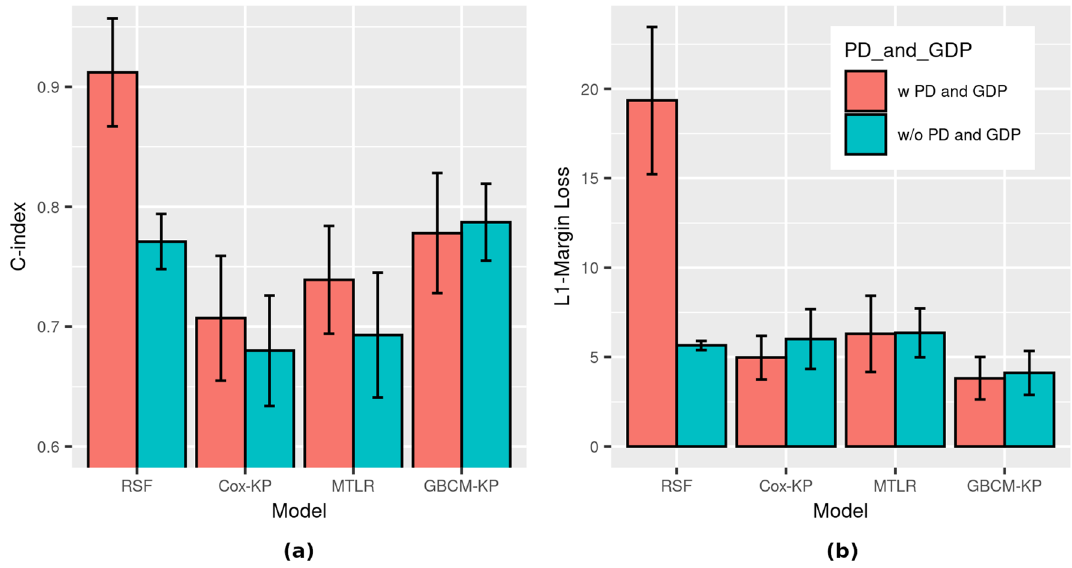
Figure 5. Survival prediction performance on dataset D3[h] (N = 1422) for hospital discharge as event of interest with age, sex, chronic disease (binary indicator), longitude, latitude, and with/without population density (PD) and gross domestic product (GDP) as covariates—( a ) C-index and ( b ) L1-Margin loss. All eight models in this experiment were D-calibrated ( p -value ≥ 0.05